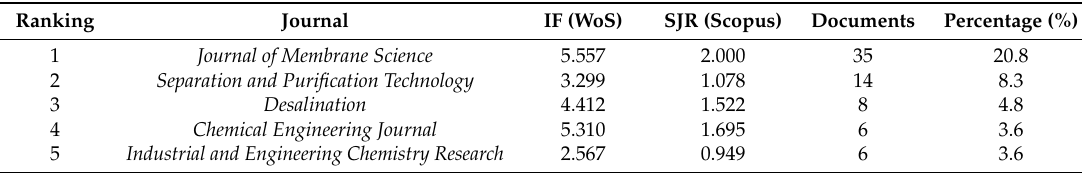
Table 2. The top 5 most productive